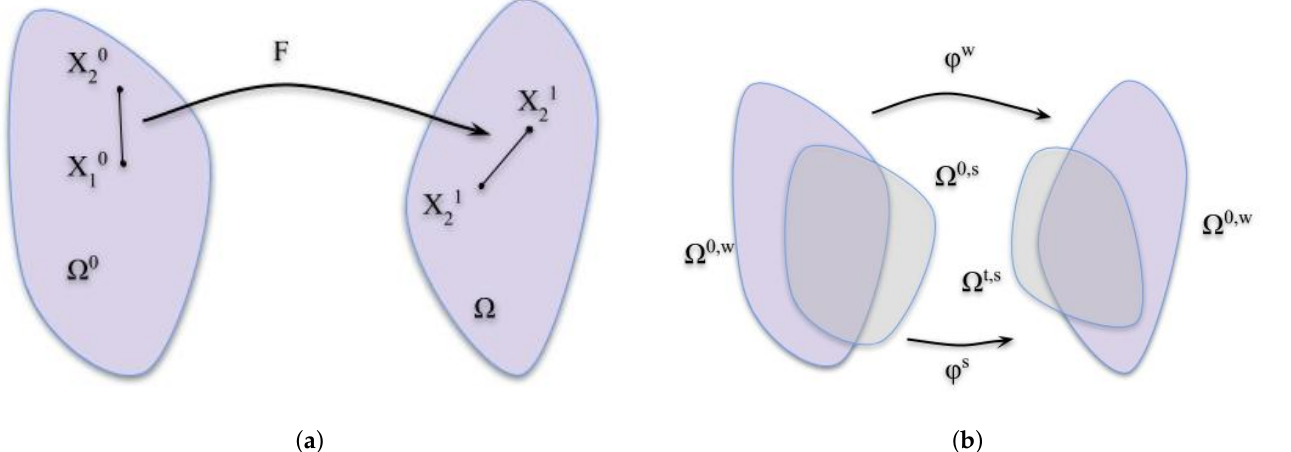
Figure 2. ( a ) Deformation of a material. ( b ) Multi-phase deformation combining water and